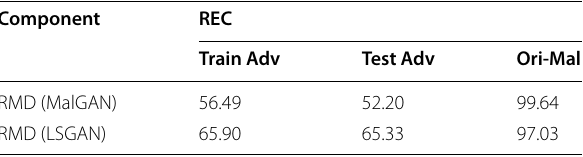
Table 12 The recognition rate of AME generated by MalGAN and LSGAN (%) Component